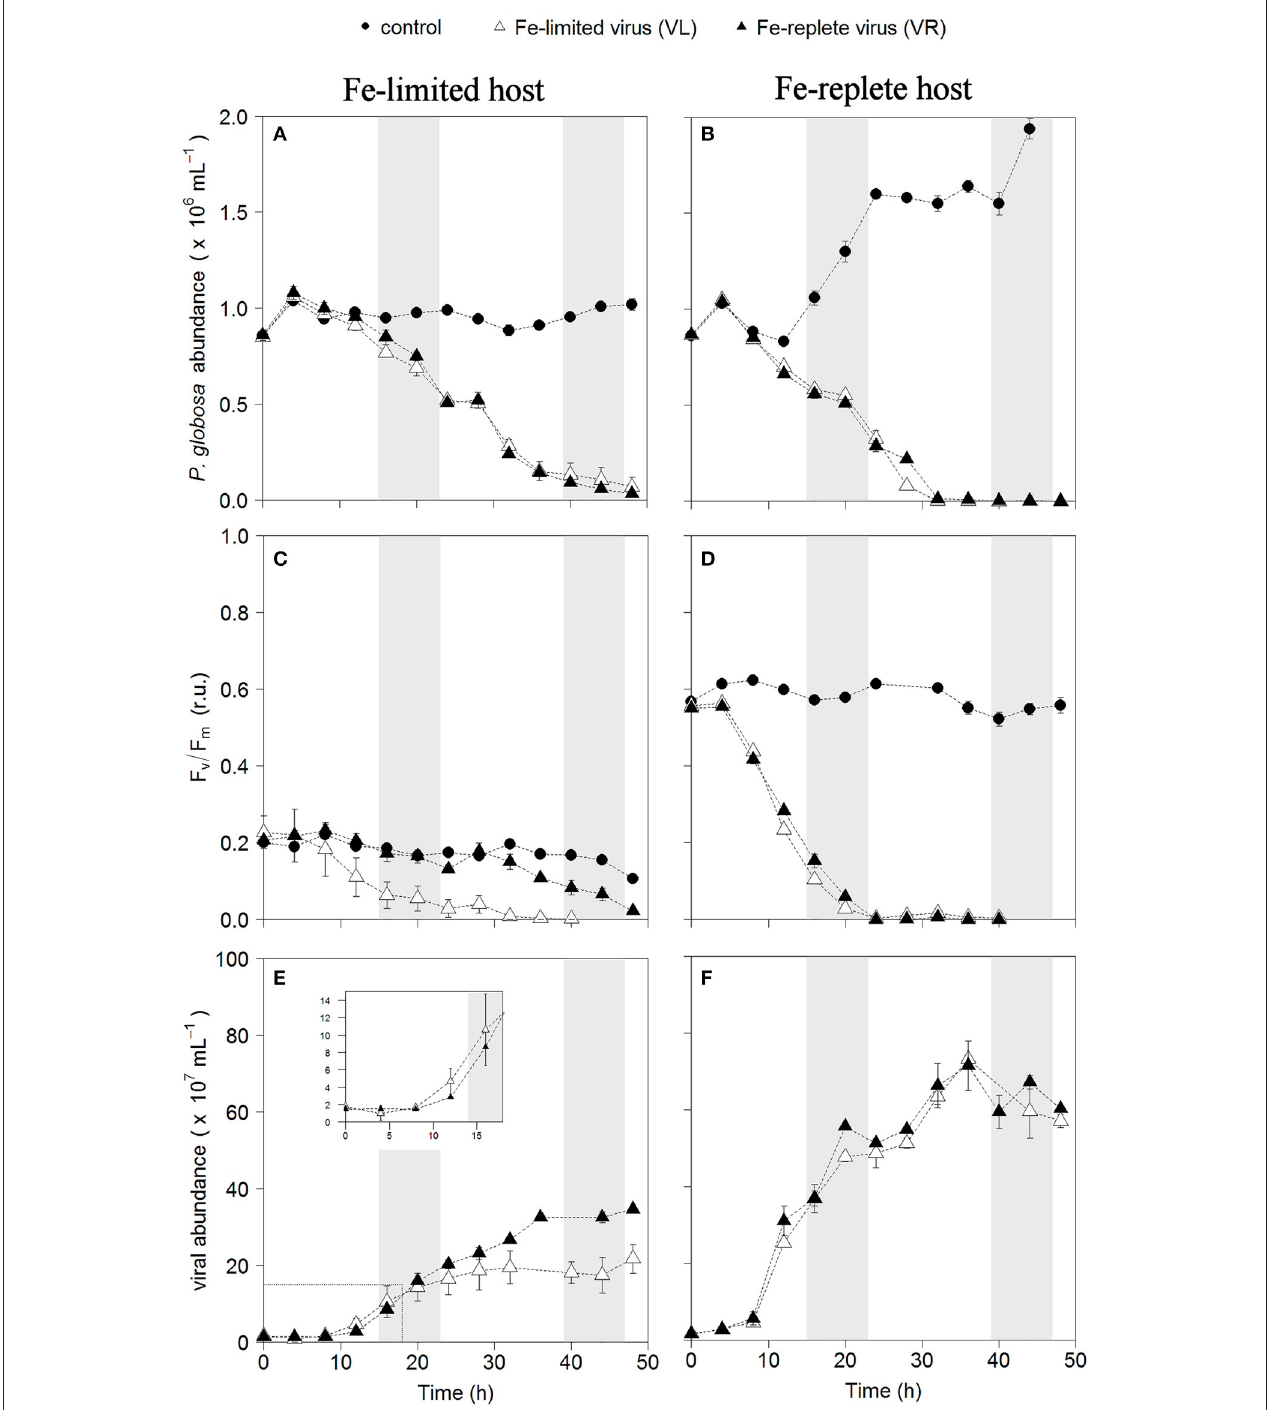
FIGURE 1 | Temporal dynamics of P. globosa viral infections: host cell abundance over time (h) in Fe-limited (A) and Fe-replete cultures (B); photosynthetic capacity (F v /F m ) over time (h) of Fe-limited (C) and Fe-replete cultures (D); viral abundance in Fe-limited (E) and Fe-replete (F) cultures. Circles represent non-infected controls, black triangles represent infections with Fe-replete host derived viruses (VR) and white triangles represent infections with Fe-limited host derived viruses (VL). Error bars indicate deviation of replicates ( n = 2); when not visible they fall within the symbols. Shaded areas indicate dark periods, explaining the slight declines in F v /F m for the Fe-replete non-infected host. Furthermore, the dark period illustrates the onset of the synchronized cell division. Inlay in (E) magnifies the first 20h post-infection.